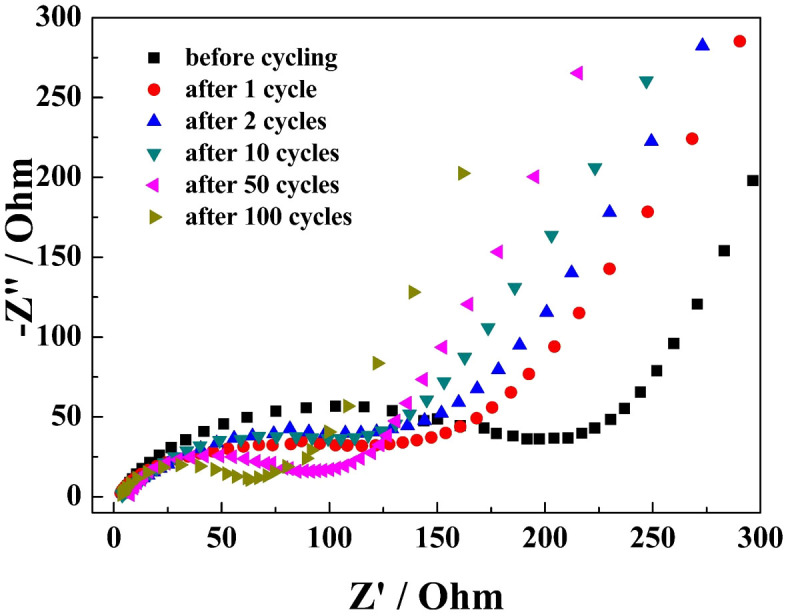
EIS of SnO2/graphene before and after 1, 2, 10, 50, 100 charge/discharge cycles.